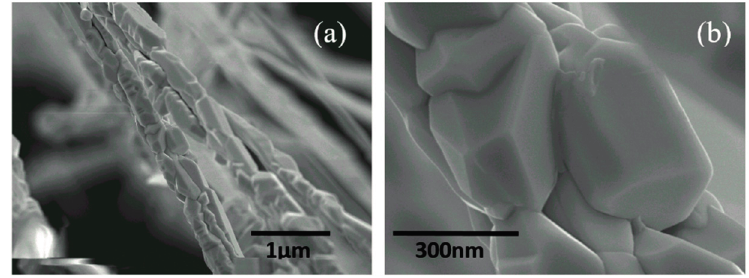
Figure 2. ( a ) Typical SEM images of tungsten oxide composite nanowires, and ( b ) magnified SEM images of selected areas.